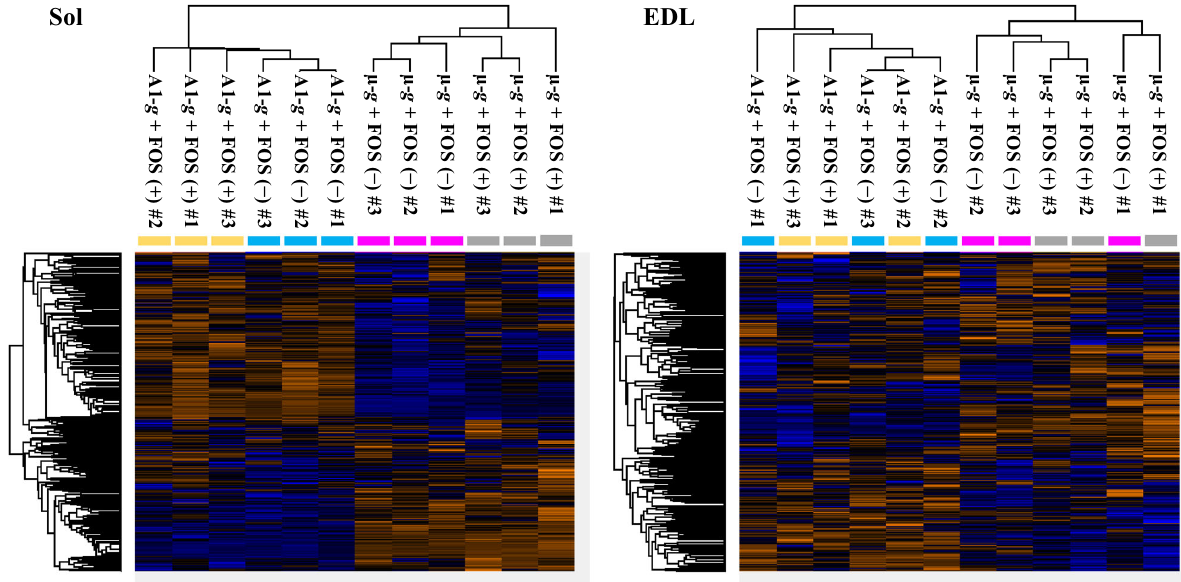
Fig. 2 Classi fi cation of soleus (Sol) and extensor digitorum longus (EDL) muscle samples according to the abundance of 1,253 proteins. The abundance of each protein is depicted in a gradient from blue (low) to orange (high). Four groups, namely, the arti fi cial 1- g (A1- g ) and fructo-oligosaccharide (FOS) ( + ), A1- g and FOS ( − ), microgravity (µ- g ) and FOS ( + ), and µ- g and FOS ( − ) groups, are indicated in yellow, cyan, magenta, and gray,